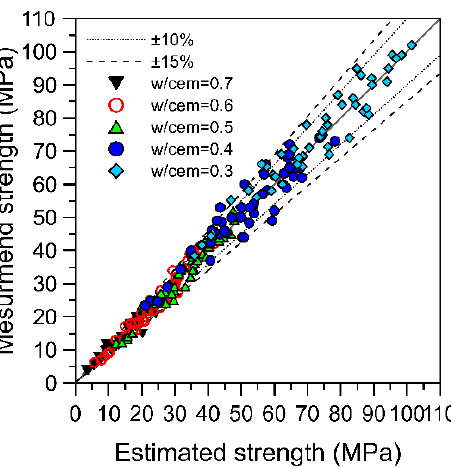
Figure 9. Comparison between actual strength measurements and concrete strength estimations obtained using the unified equation.